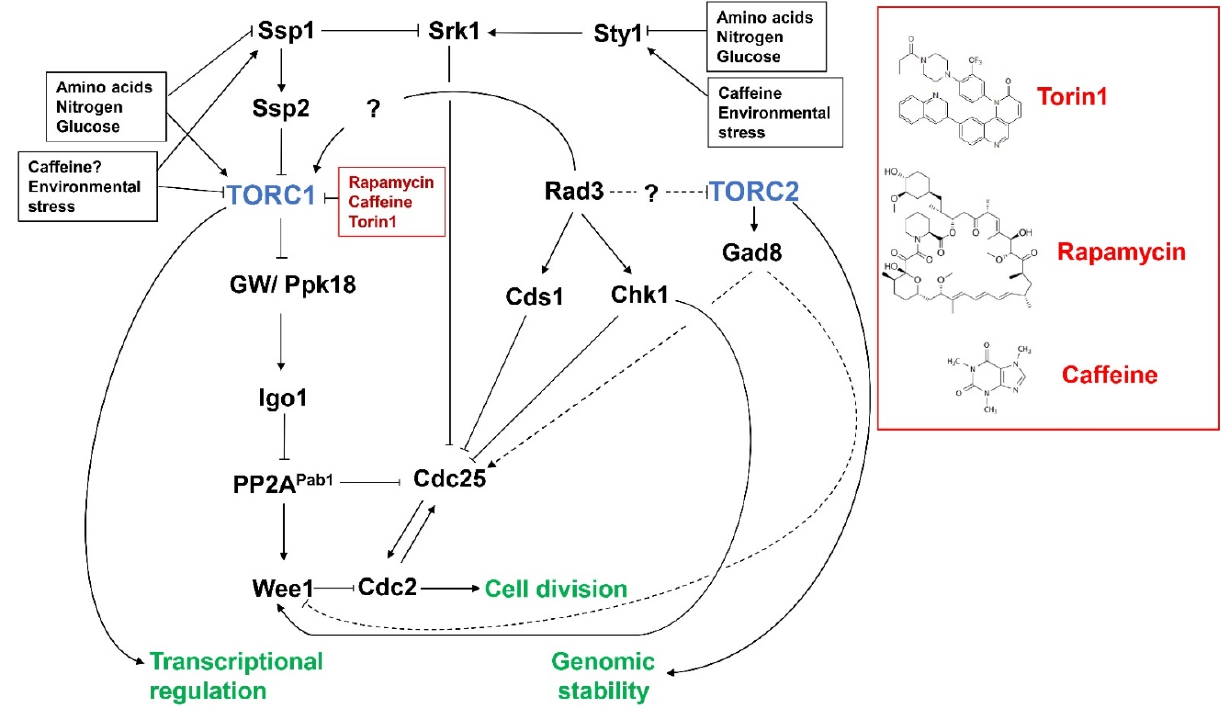
Figure 2. Interaction of DNA damage response (DDR), environmental stress response (ESR), and TORC1/TORC2 signaling in S. pombe . TORC1 and TORC2 play distinct roles in regulating cell growth and division as well as responses to environ- mental stresses and nutrient availability. Activation of Rad3 by DNA damage or replication stress leads to the activation of Chk1 and Cds1, respectively. Chk1 and Cds1 inhibit Cdc25 and activate Wee1 (or Mik1) to inhibit Cdc2 and delay cell cycle progression. Direct inhibition drives cells into mitosis via the Ppk18-Igo1-PP2A Pab1 pathway in the presence of DNA damage, suggesting Rad3 may maintain TORC1 activity during cell cycle arrest. Conversely, TORC2 is required for the resumption of cell cycle progression once DNA repair has been affected. Rad3 may also regulate TORC2 activity during the DDR. Caffeine may directly inhibit TORC1 as a low affinity ATP competitor. Alternatively, caffeine may indirectly inhibit TORC1 via activation of the ESR and Ssp1-Ssp2 (AMPK) pathways.